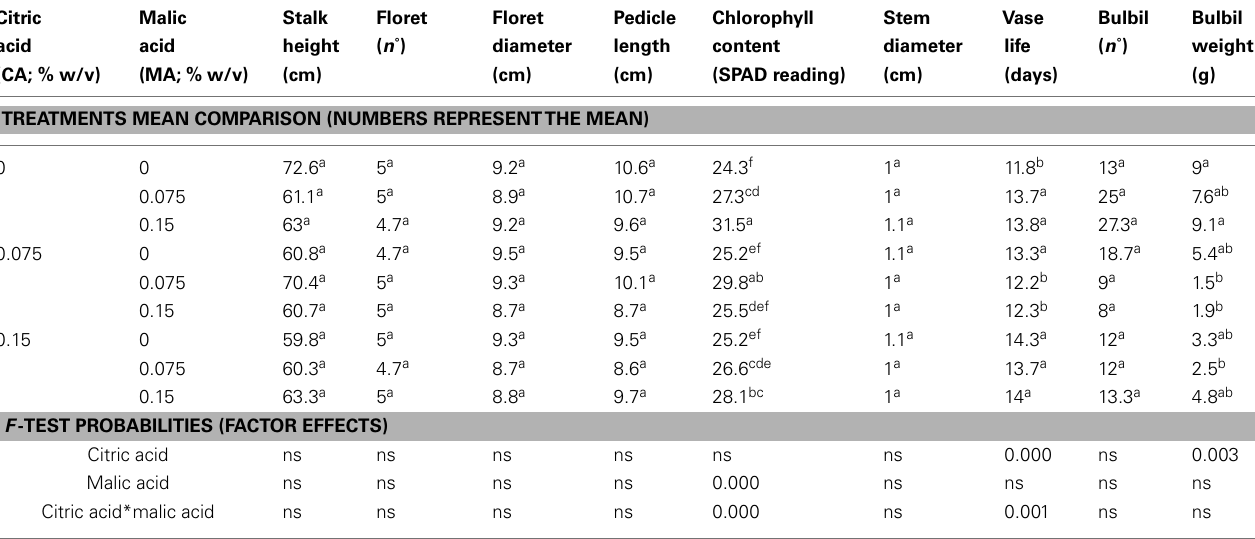
Table 1 | Effect of pre-harvest foliar application of citric acid and malic acid on plant growth, chlorophyll content, and vase life of Lilium . Citric acid